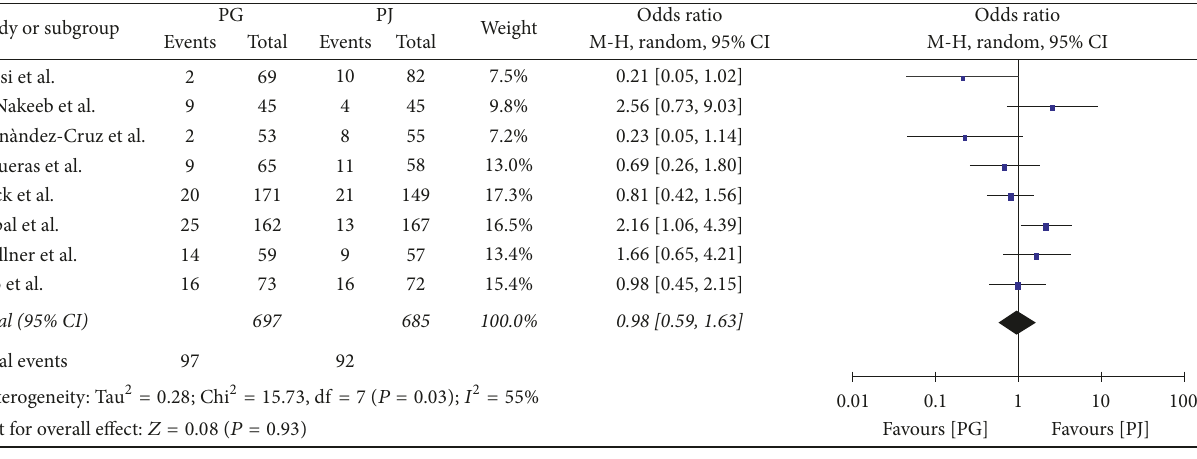
Figure 4: (a) Clinically significant postoperative pancreatic fistula, (b) postoperative pancreatic fistula, (c) delayed gastric emptying, and (d) clinically significant delayed gastric